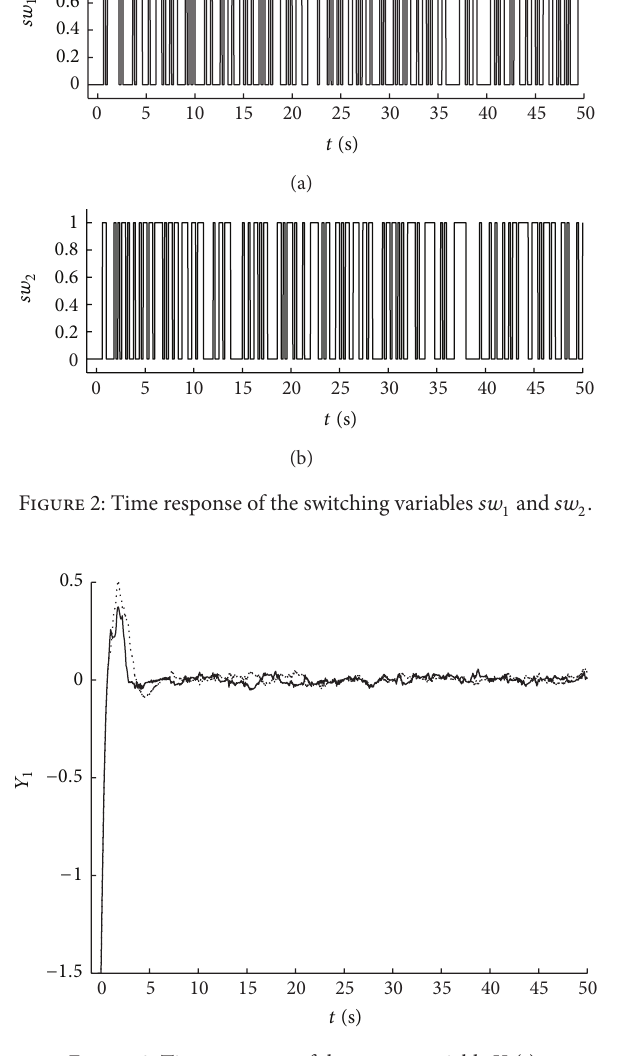
Figure 3: Time response of the output variable 𝑌 1 (𝑡) . Table 1: The maximal allowable delay for different parameters 𝑘 when 𝛽 is 0.1.